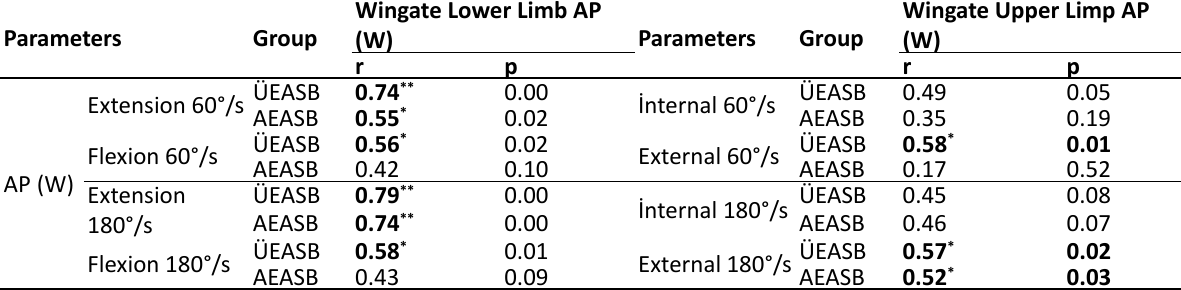
Table 7. Correlation analysis between the wingate data of the participants and their dominant leg and arm isokinetic